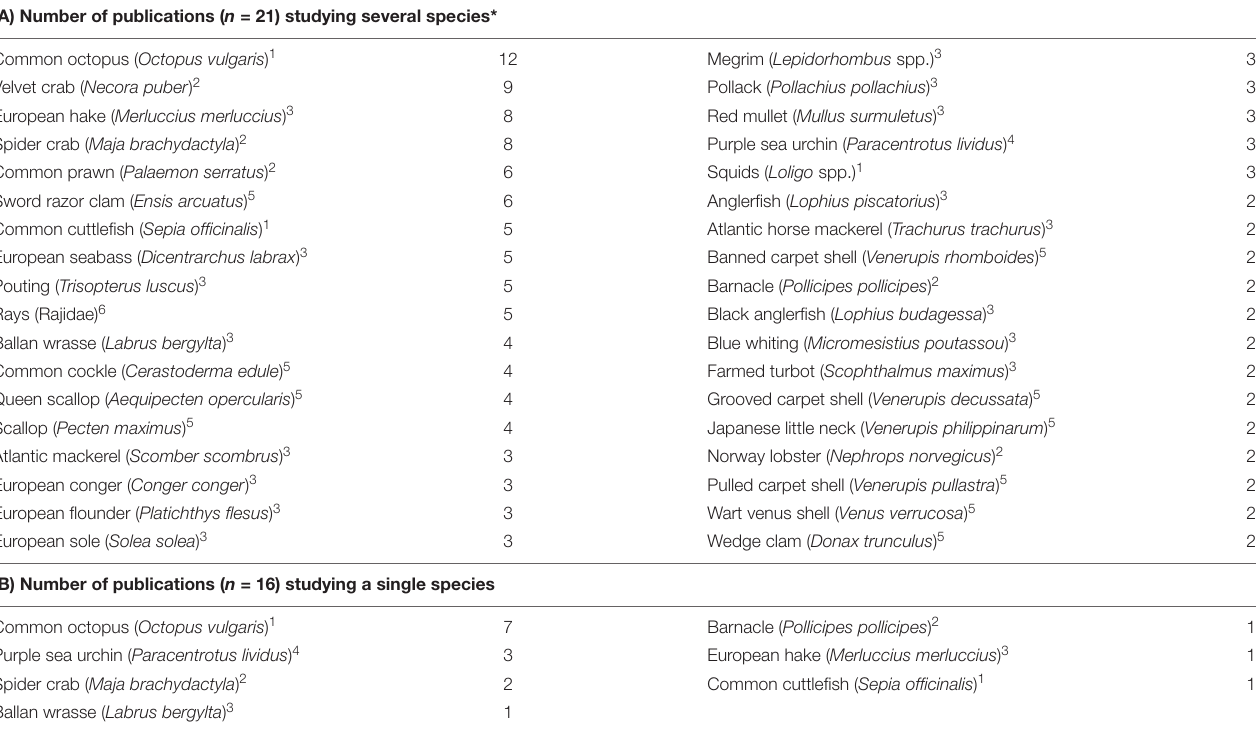
TABLE 2 | Species studied ( A: several species and B: one species) in the analyzed publications. Subindexes: 1 Cephalopod, 2 Crustacean, 3 Fish, 4 Echinoderm, 5 Bivalve, and 6